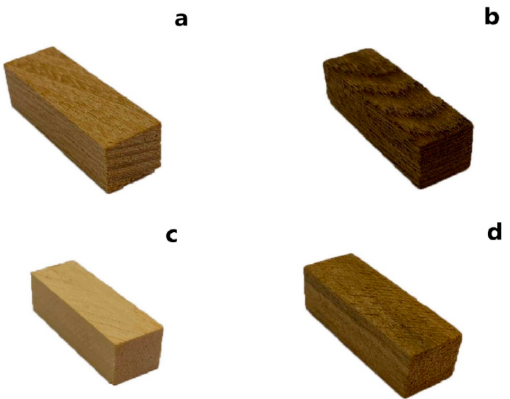
Figure 1. Recently cut ( a ) and archaeological elm ( b ) and recently cut ( c ) and archaeological poplar ( d ).